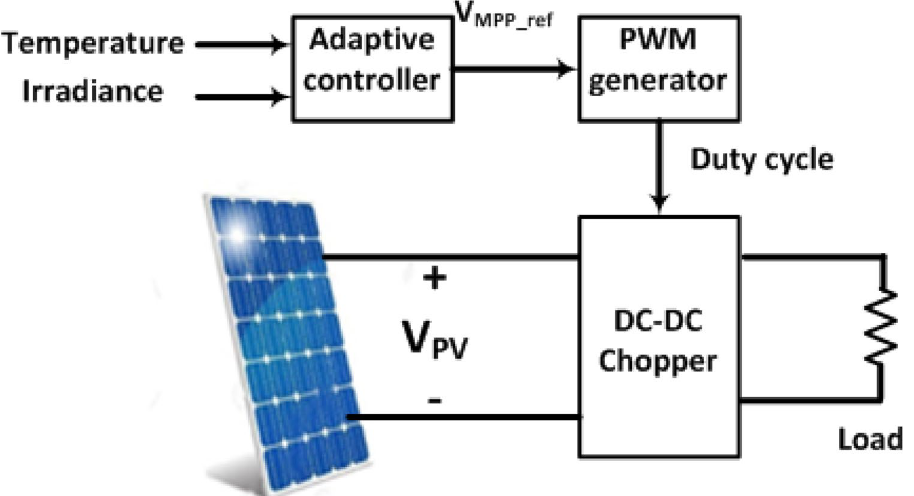
Figure 10. Block diagram of setup